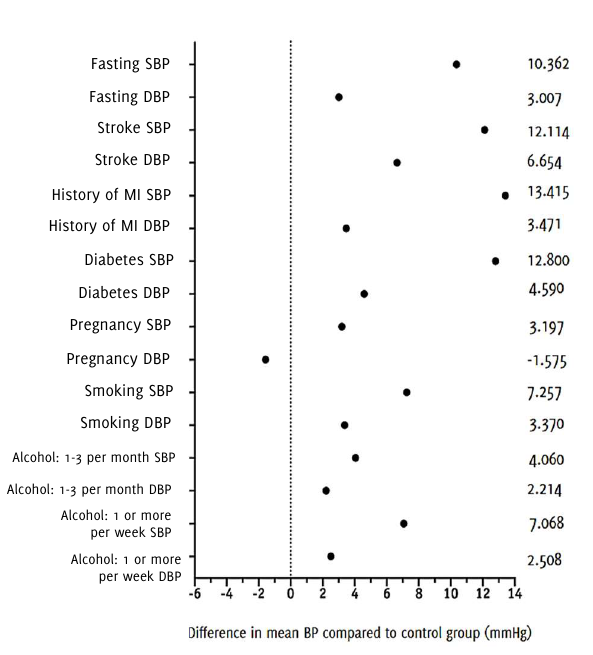
Figure 4 . Change in Mean Systolic and Diastolic Blood Pressure Compared to Non-hypertensives for Associated Factors to Changes in Blood Pressure.